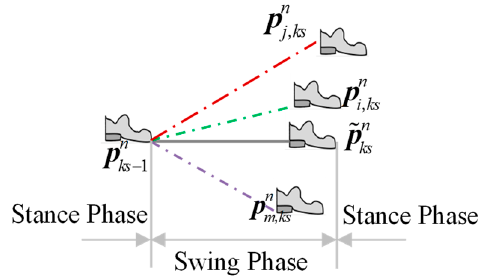
Figure 5. Pedestrian positions calculated by IMU with different drift errors during a step.